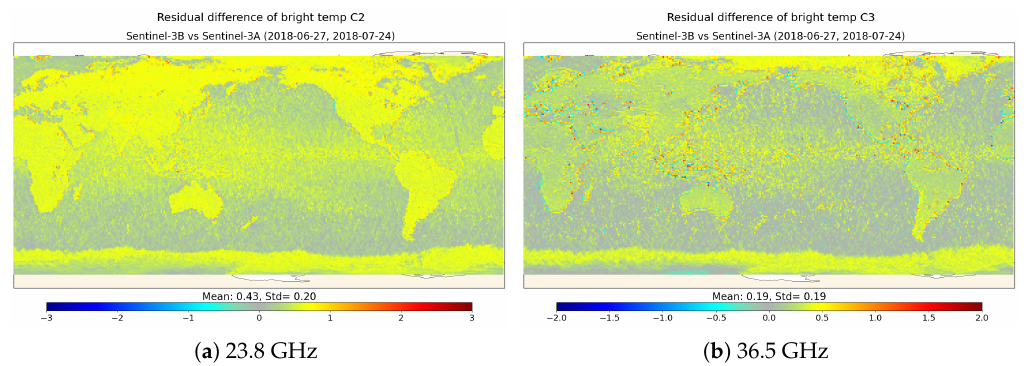
Figure 13. Residual differences between S3A and S3B brightness temperatures after S3B inter-calibration for cycle 10 of